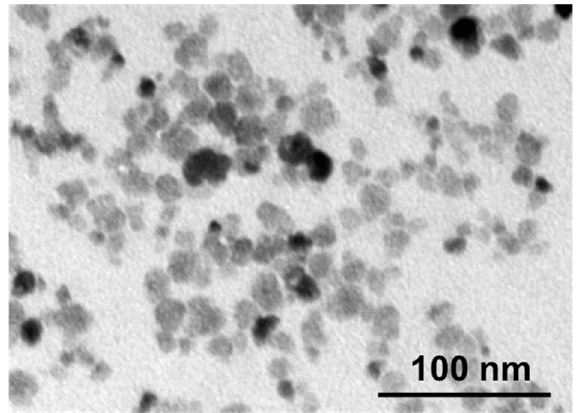
Figure 1. TEM micrograph of investigated cobalt ferrite MNPs.